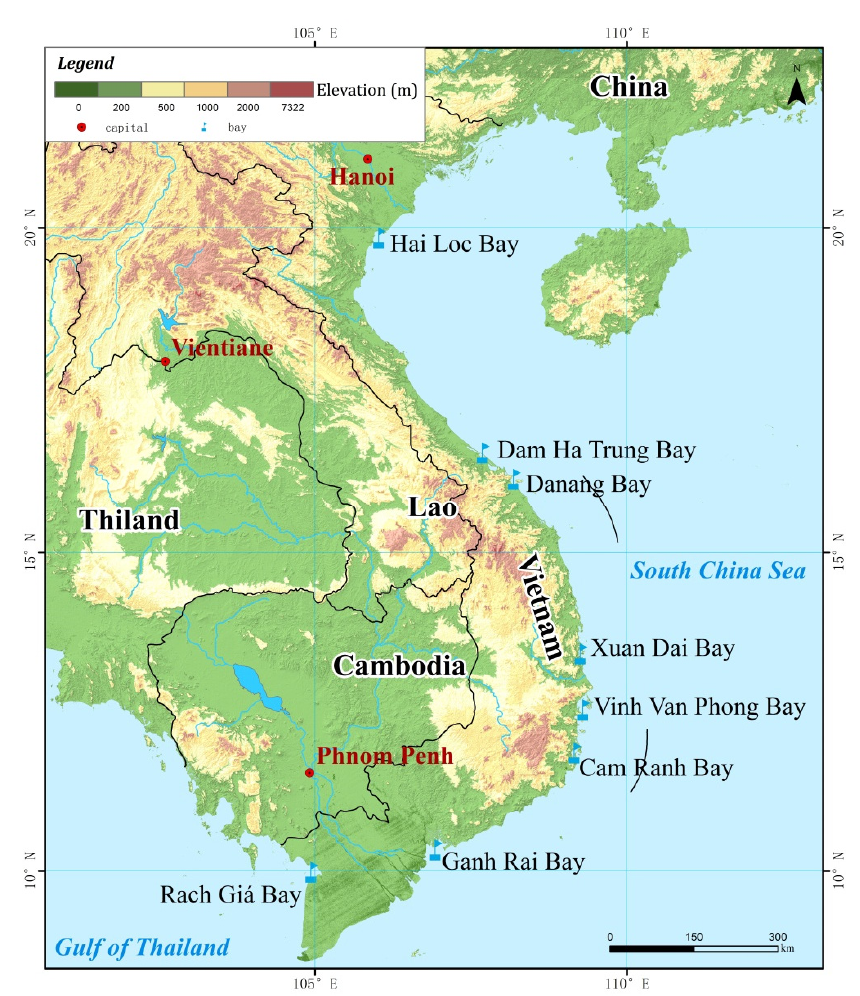
Figure 1. Location of bays along the coast of Vietnam.